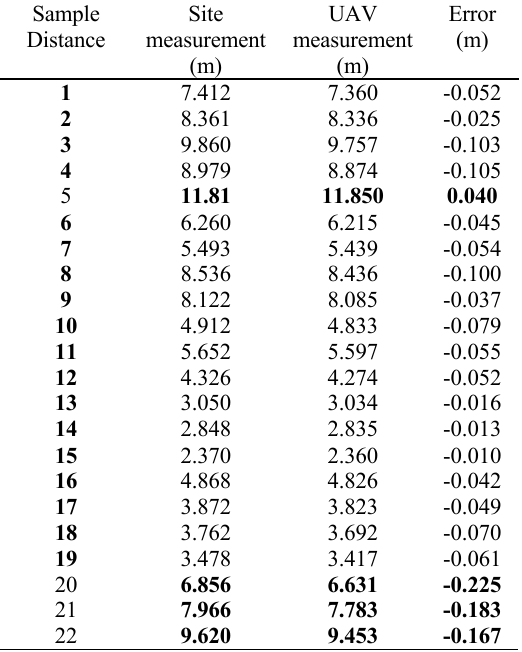
Table 2. Errors for POI technique Sample